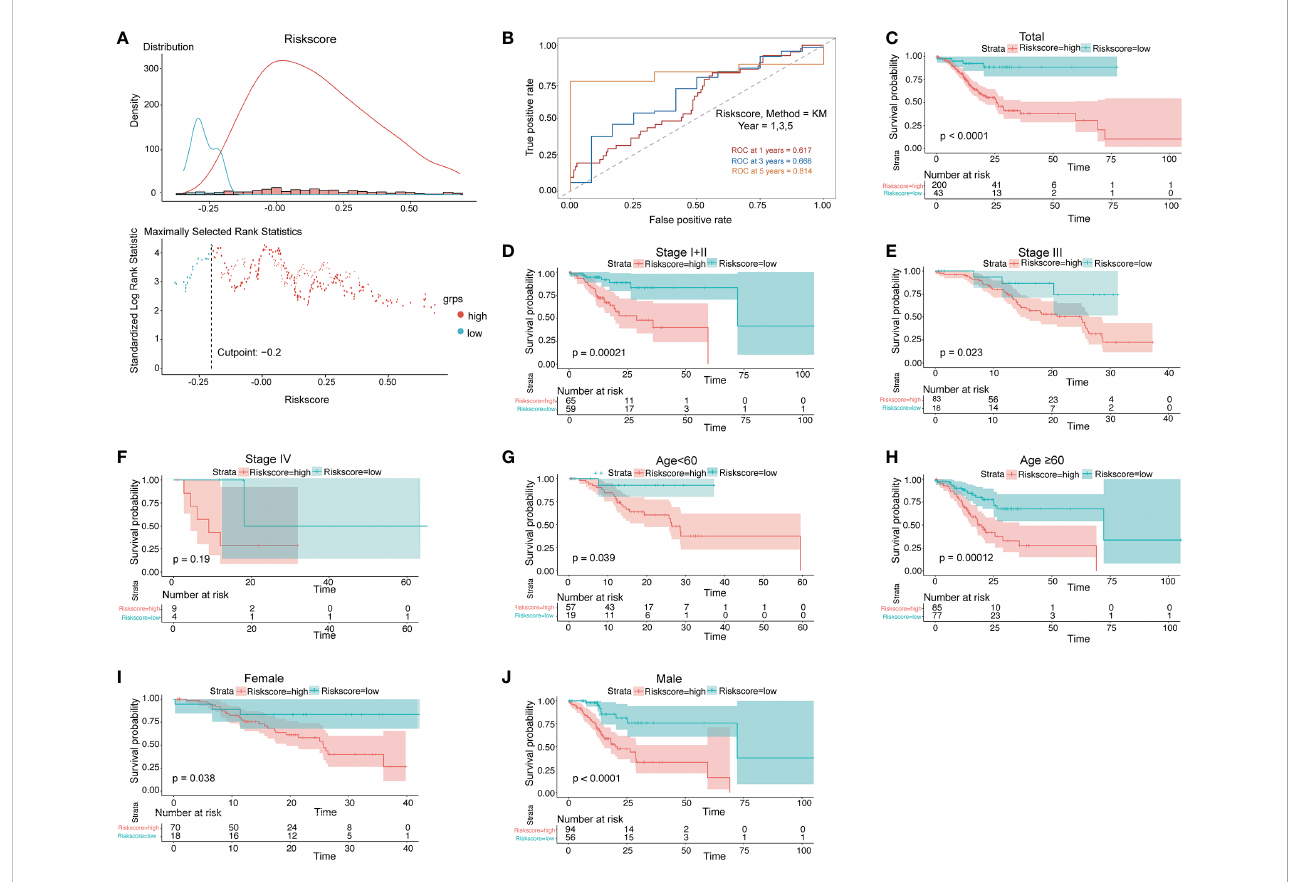
FIGURE 2 Prognostic OS analysis of the four-gene signature model in the training cohort. (A) The distribution and cutoff value of the risk scores in the training cohort. (B) AUC of time-dependent ROC curves veri fi ed the prognostic performance of the risk score in the training cohort. (C – F) Kaplan – Meier curves for the OS of patients in the high-risk group and low-risk group in the TNM stage (total, I+II, III, IV). (G, H) Kaplan – Meier curves for the OS of patients in the high-risk group and low-risk group for age (age<60, age ≥ 60) in the training cohort. (I, J) Kaplan – Meier curves for the OS of patients in the high-risk group and low-risk group for gender (female, male) in the training